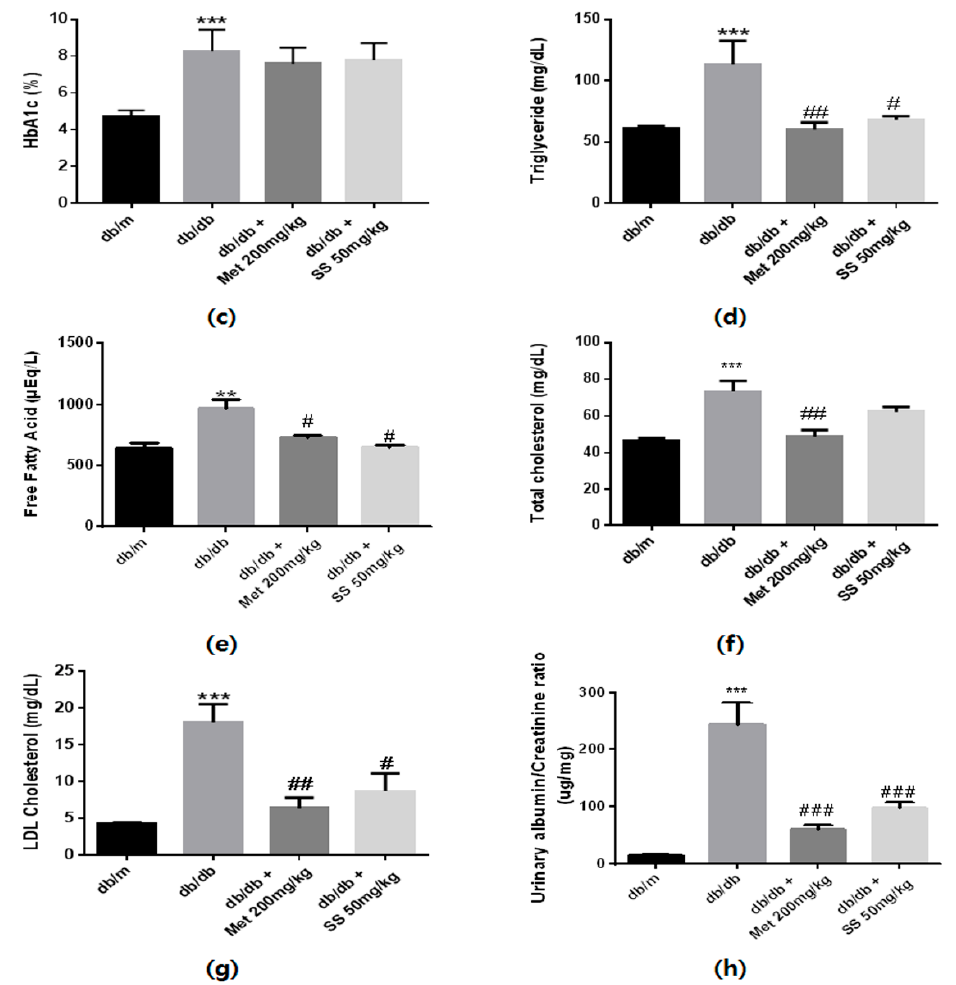
Figure 3. Diabetes parameters and lipid profiles of db/db mice. ( a ) Time course of body weight changes in mice. ( b ) Fasting blood glucose levels of db/m and db/db mice following a 6-week treatment period and after 12 h of fasting. ( c ) Glycated hemoglobin (HbA1c) levels of db/m and db/db mice after a 6-week treatment period. ( d ) Serum triglyceride levels of db/m and db/db mice after a 6-week treatment period and 12 h of fasting. ( e ) Serum-free fatty acid levels of db/m and db/db mice after a 6-week treatment period and 12 h of fasting. ( f ) Serum total cholesterol levels of db/m and db/db mice after a 6-week treatment period and 12 h of fasting. ( g ) Serum low-density lipoprotein (LDL)-cholesterol levels of db/m and db/db mice after a 6-week treatment period and 12 h of fasting. ( h ) Urinary albumin/creatinine ratio of db/m and db/db mice after a 6-week treatment period and 12 h of fasting. Lipid profiles and urine albumin/creatinine ratio were determined using a commercial enzyme-linked immunosorbent assay kit according to the manufacturer’s protocol. Value are means ± standard error of the mean (SEM, ** p < 0.01; *** p < 0.001 vs. db/m; # p < 0.05, ## p < 0.01, and ### p < 0.001 vs. db/db).